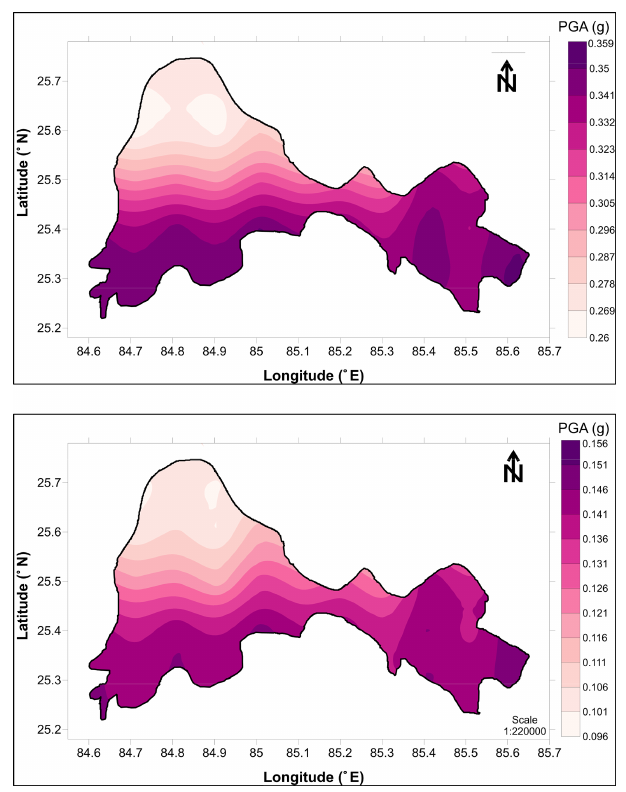
Figure 10. (a) Weighted-mean PGA map of Patna SSA for 2% probability of exceedance in 50 years using the Frankel approach (1995). (b) Weighted-mean PGA map of Patna SSA for 10% prob- ability of exceedance in 50 years using the Frankel approach (1995).